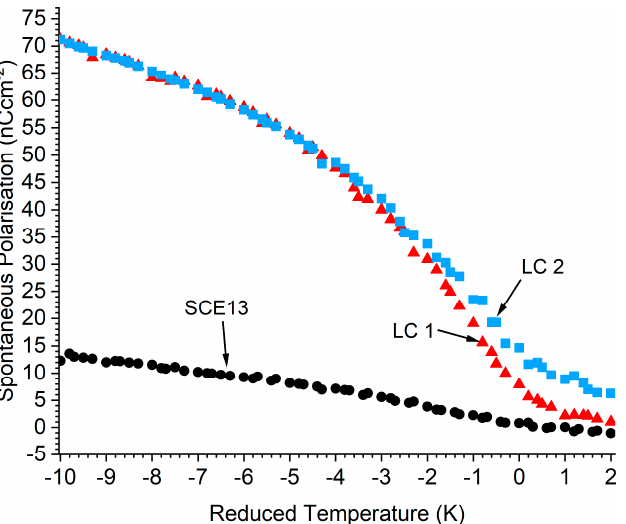
Figure 3. Maximum spontaneous polarisation ( P S ) measured as a function of reduced temperature relative to the SmA–SmC* transition for SCE13 (black circles), TGB A –SmC α * for LC 1 (red triangles), and SmA–SmC α * for LC 2 (blue squares). The uncertainty in P S = ± 1 nC cm − 2 . LC 1 shows a discontinuous transition, while LC 2 and SCE13 show a continuous